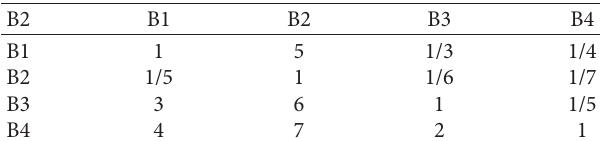
Table 5: The judgment matrix of major criteria with respect to information level (B2).